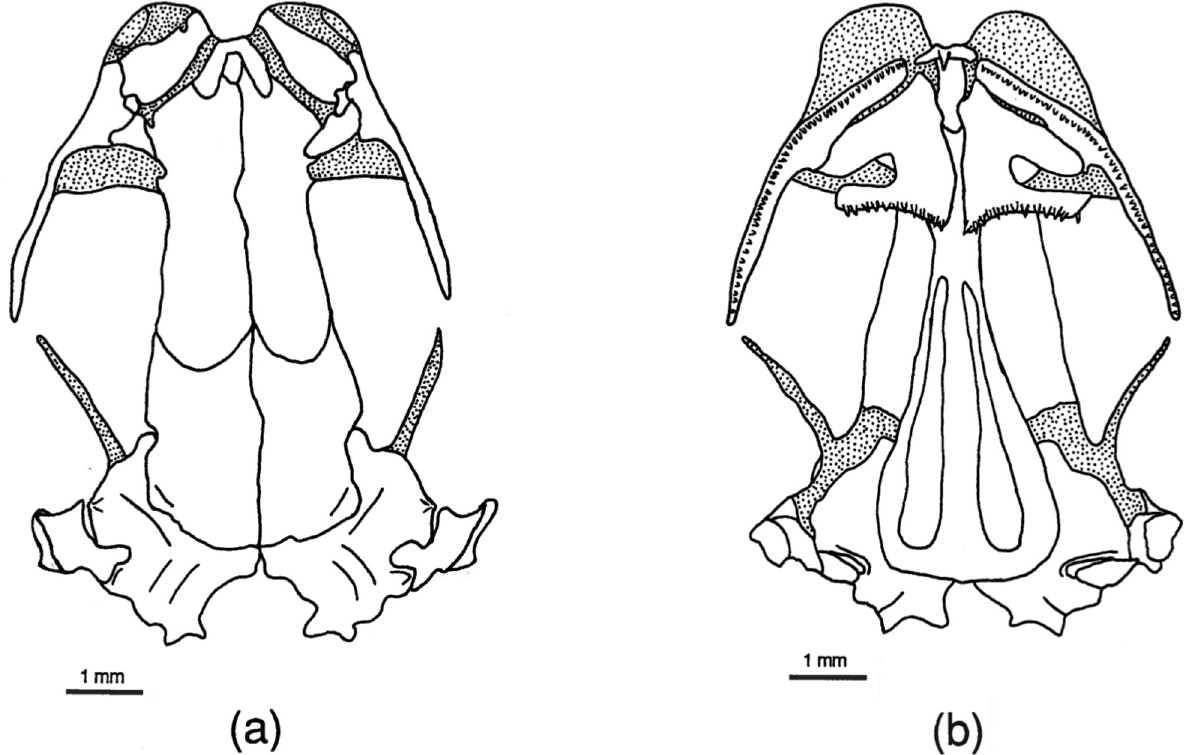
Fig 12. Pseudoeurycea leprosa skull. Drawings of dorsal (a) and ventral (b) aspects of the skull of Pseudoeurycea leprosa (MVZ 147092). Stippled areas represent cartilage. Elements as labeled in Fig 1.